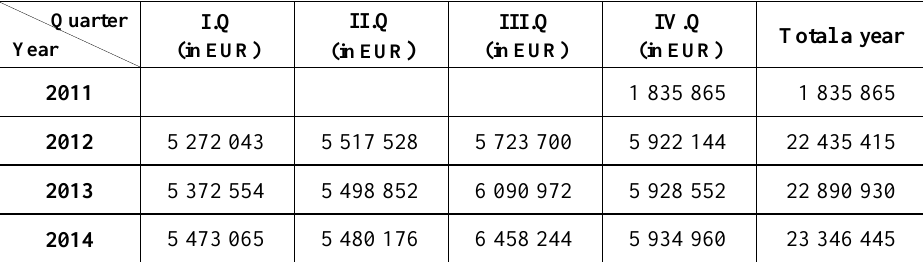
Table 9 – Overview of outputs of LC